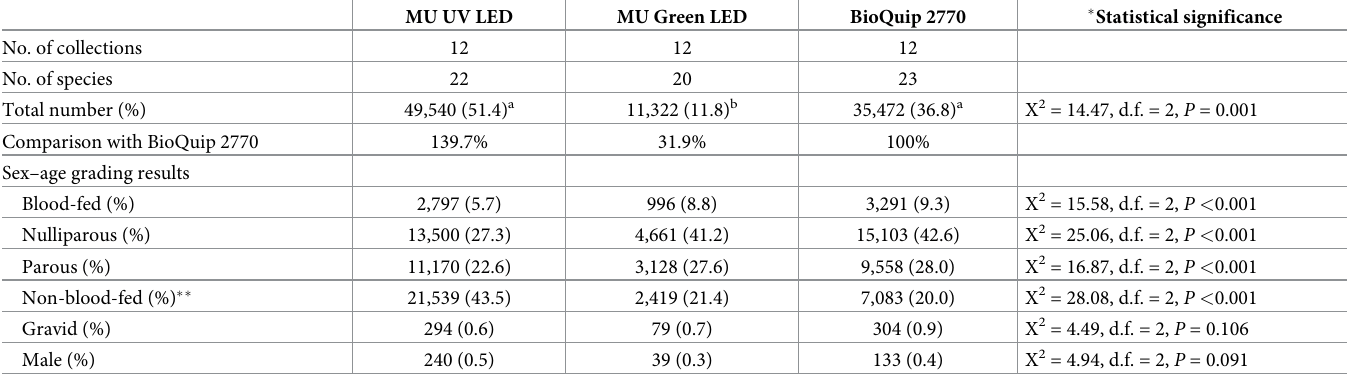
Table 3. Summary of Culicoides midges collected and overall sex–age grading results with three different LED light traps over 12 nights between 26th July and 7th August 2020 in Sai Yok District, Kanchanaburi Province,